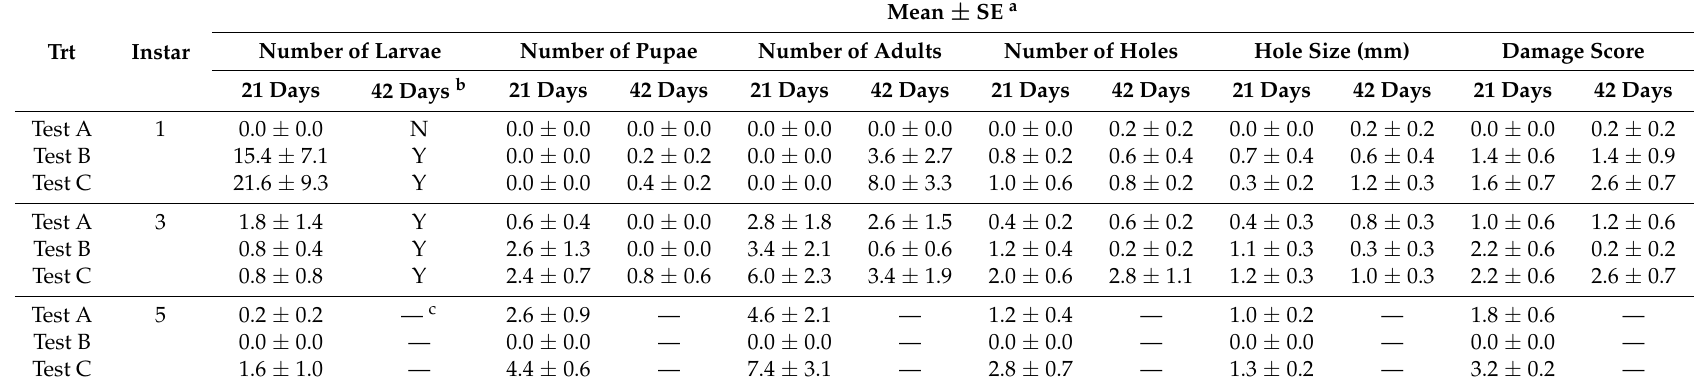
Table 3. Number of larvae, pupae, and adults of P. interpunctella found inside packages of energy bars after 21 days and 42 days of infestation with first, third, and fifth instars, and extent of damage to packages and energy